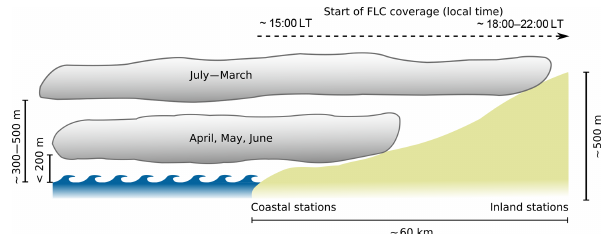
Figure 6. Schematic illustrating the observed seasonal cycle in cloud vertical characteristics and the dependence of the diurnal FLC cycle on the distance to the